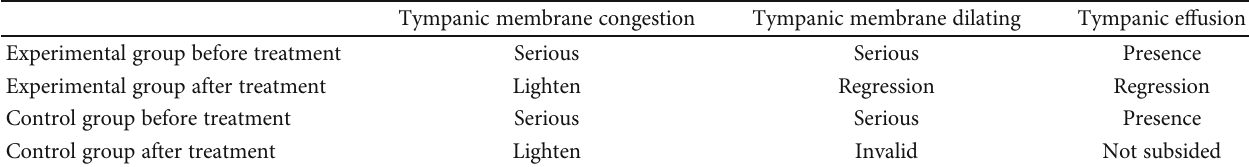
Table 8: Tympanic membrane morphology changers after 4